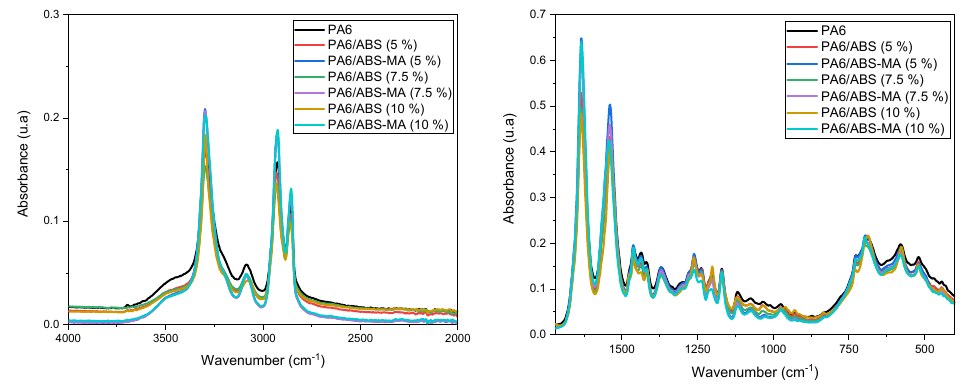
Figure 5. FTIR spectra of pure PA6 and the blends, respectively.